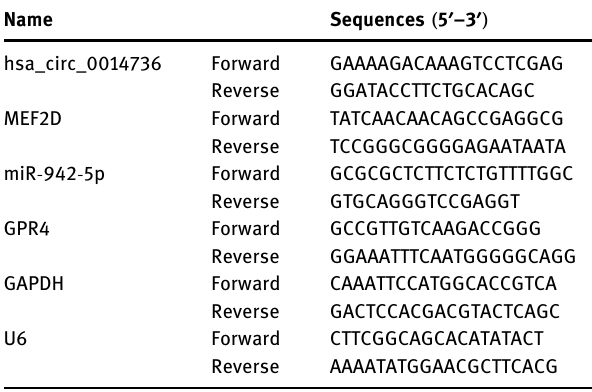
Table 2: Primers sequences used for qRT - PCR Name Sequences ( 5 ′– 3 ′